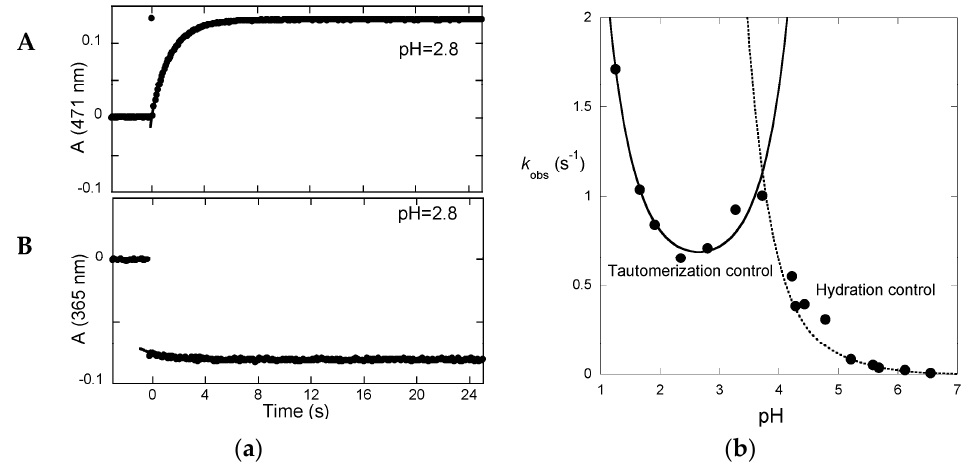
Figure 7. ( a ) Transient absorption upon a light flash applied to an equilibrated solution of P3 at pH = 2.8. A mono-exponential curve-fittings gives: k obs = 0.7 s − 1 ; A : flavylium formation; B : trans -chalcone consumption; and ( b ) plot of the apparent rate constant as a function of